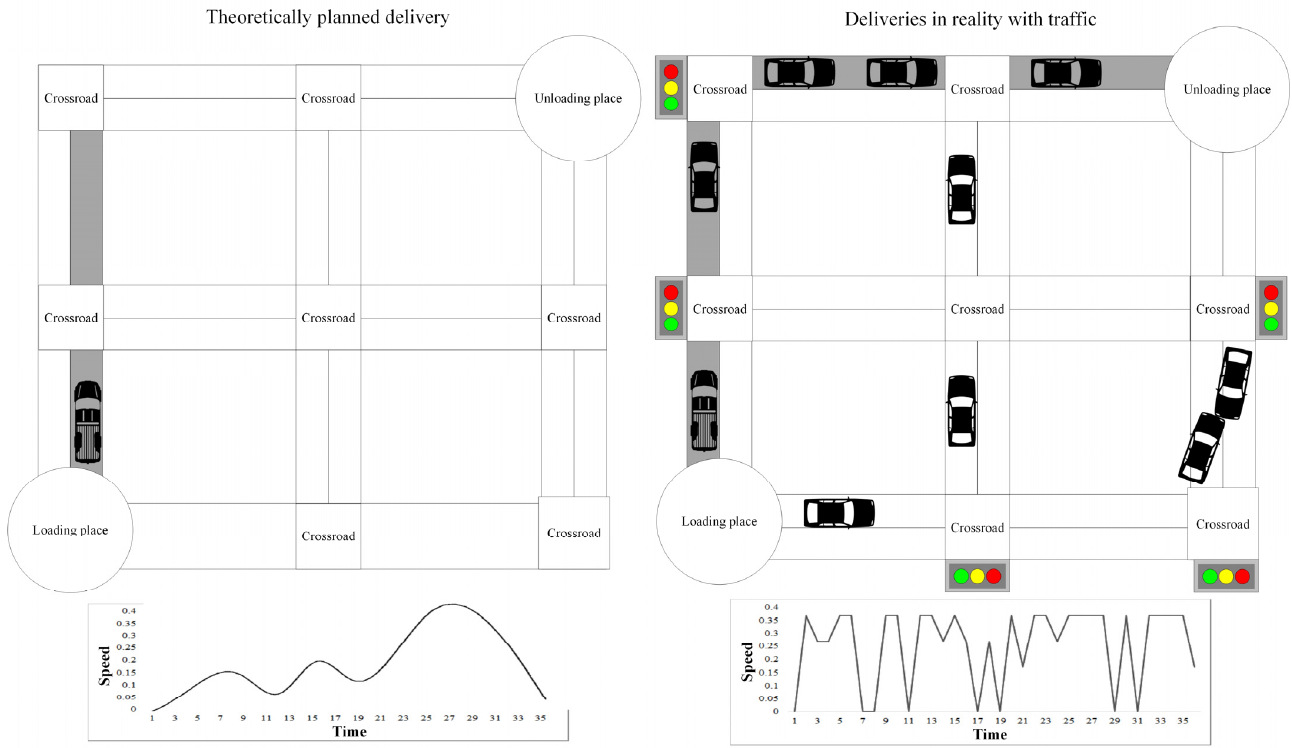
Figure 3. Comparison of the planned and actual deliveries.